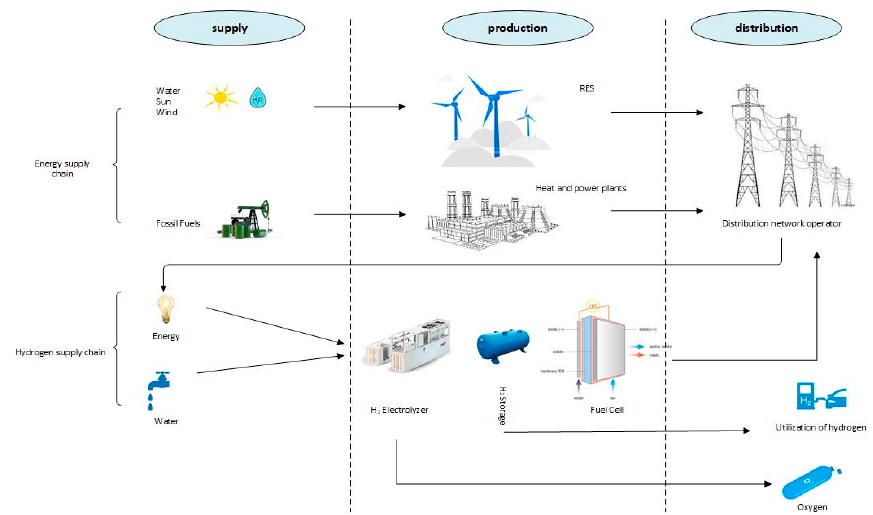
Figure 1. Energy supply chain cooperating with the hydrogen supply chain. Source: own elabora- tion.